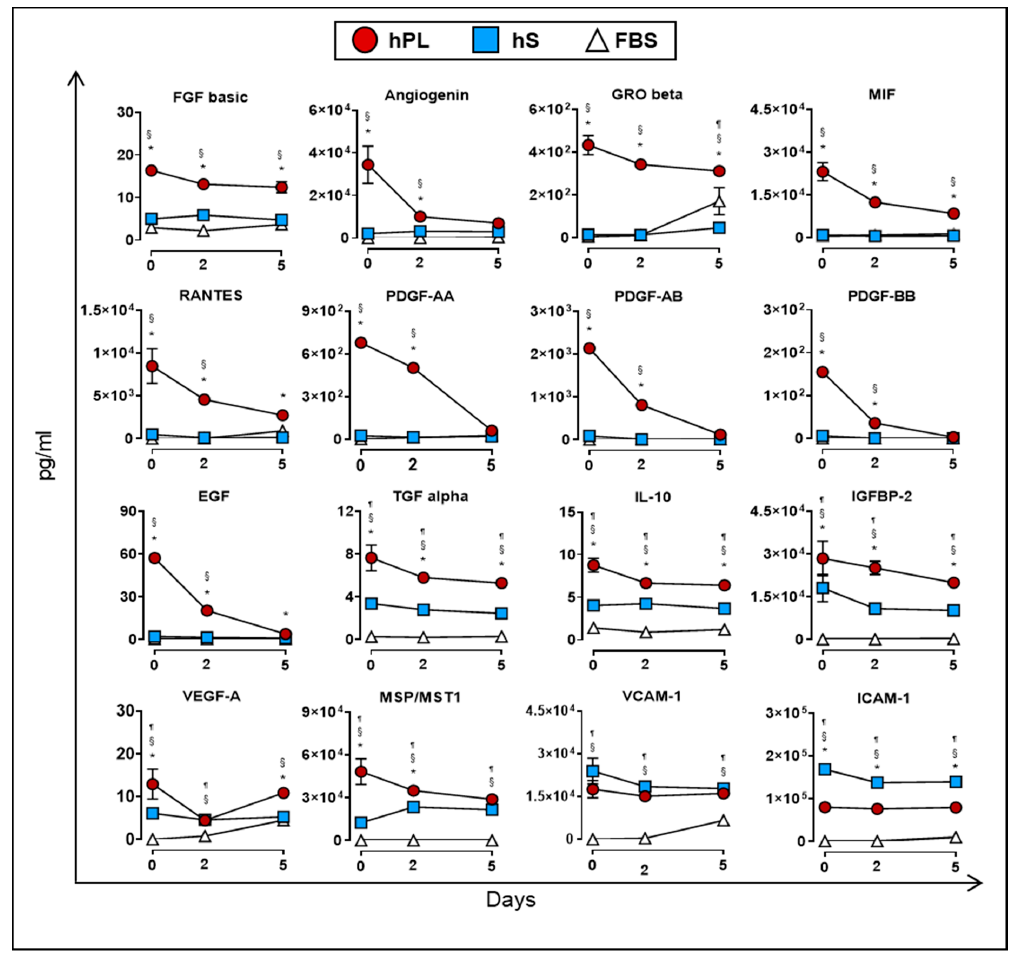
Figure 7. Uptake of cytokines and growth factors measured in supernatants from WJ-MSC cultured in hPL ( n = 4), hS ( n = 3) and FBS ( n = 1) at days 0, 2 and 5 ( n = 3 donors). Data are represented as mean of concentration ±SD. § p < 0.05 FBS vs. hS, ¶ p < 0.05 FBS vs. hLP, * p < 0.05 hLP vs. hS, as analyzed by Tukey’s test.